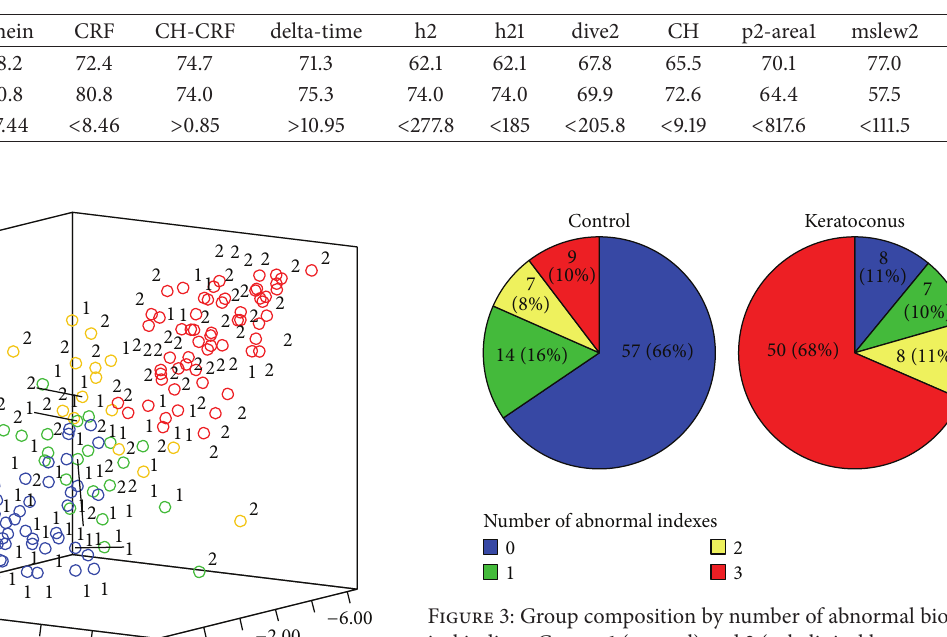
Table 3: Diagnostic capacity of individual descriptors. Specificity, sensitivity, and cutoff value for diagnosing subclinical keratoconus are shown for the 12 corneal waveform descriptors with the highest area under the curve in decreasing order.